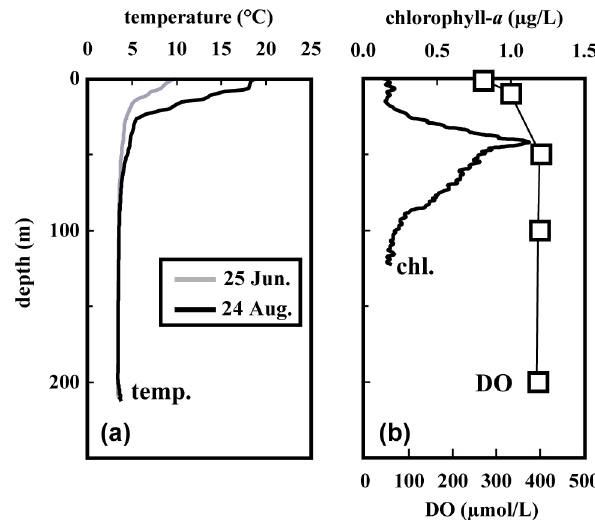
Fig. 3. Vertical distribution of temperature in June 2007 (grey line) and August 2007 (bold line) (a) , chlorophyll- a concentration (bold line) and dissolved oxygen concentration (DO; white square) in Au- gust 2007 (b) at Lake